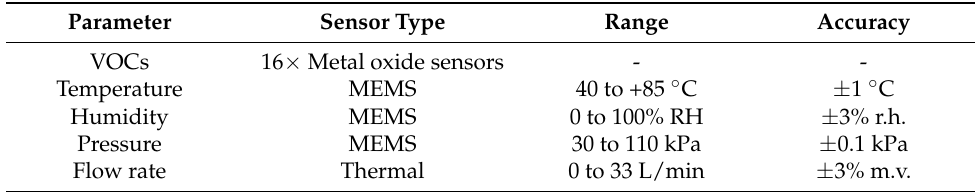
Table 1. Sensors included in the electronic nose.